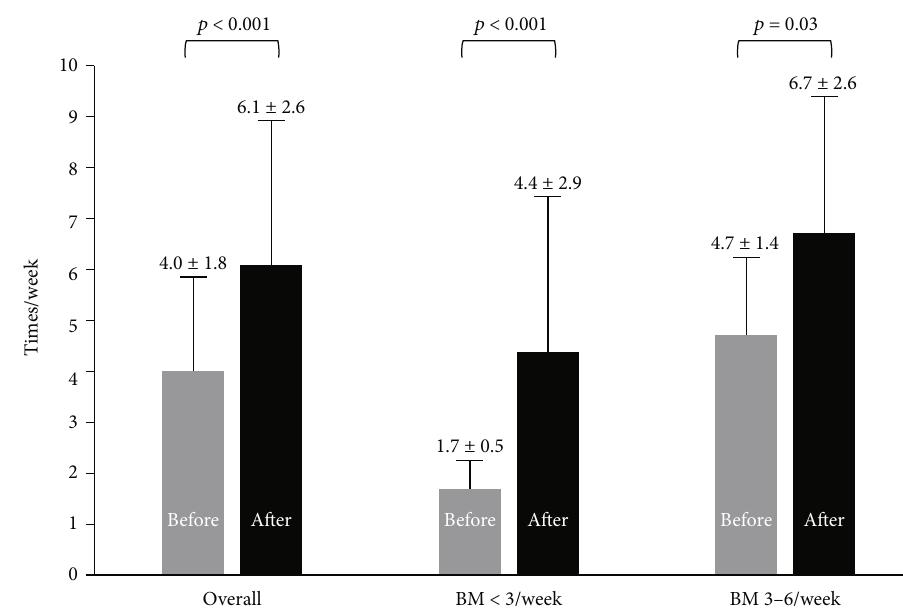
Figure 3: Changes of spontaneous bowel movements before and after short-duration PEG+E both for those with < 3 BMs/week and 3-6 BMs/week. PEG+E: polyethylene glycol plus electrolytes; BM: spontaneous bowel